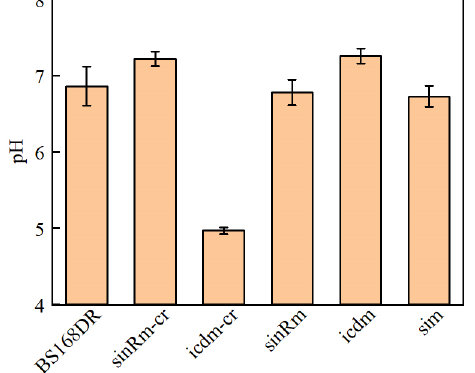
Figure 6. Comparison of pH between BS168DR and engineering strains. The pH was determined at 48 h of fermentation.